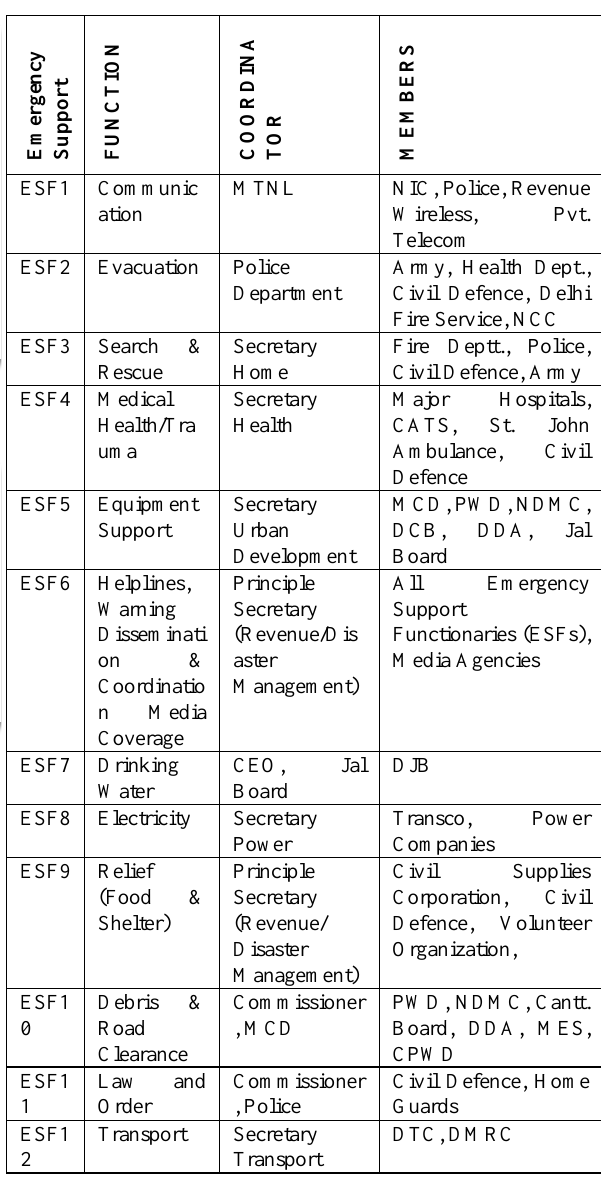
Table 3: ESF Delhi; Source: